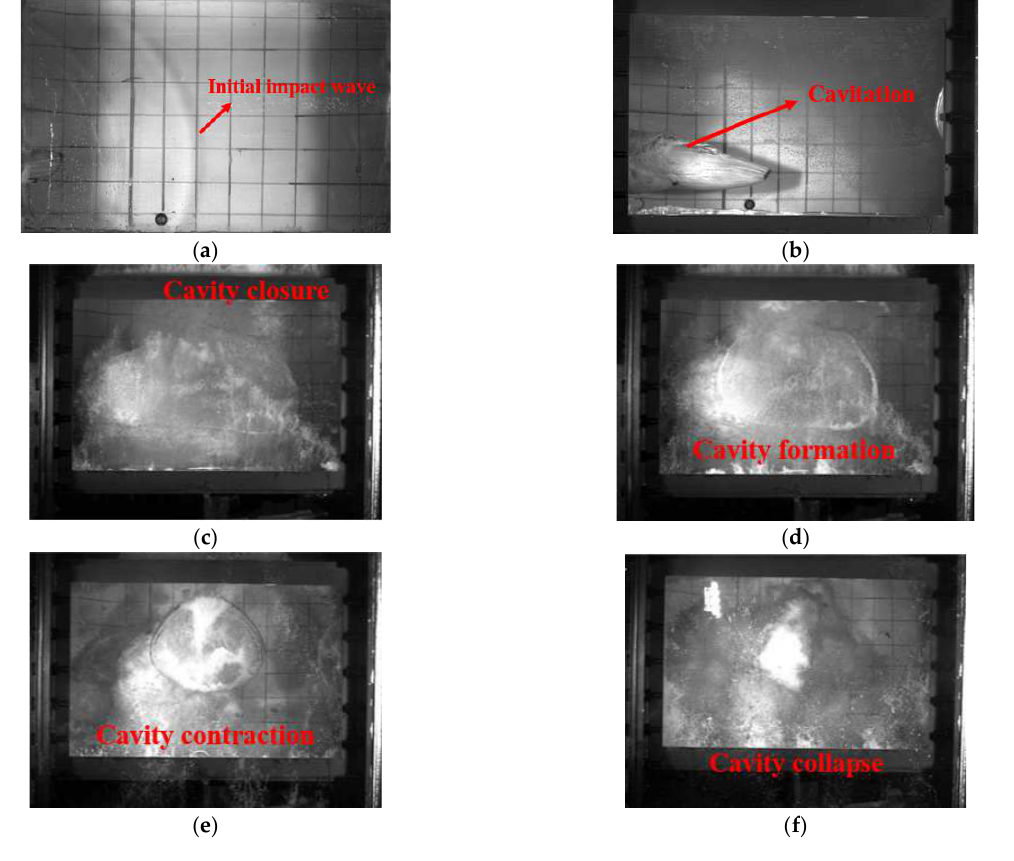
Figure 16. Pressure loading stage. ( a ) 100 us; ( b ) 250 us; ( c ) 2300 us; ( d ) 3300 us; ( e ) 8000 us; ( f ) 11,300 us. Table 7. Peak value and specific impulse of initial pressure and cavitation